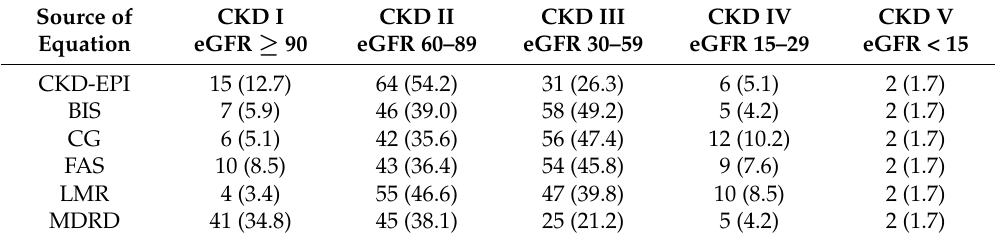
Table 3. Classification of chronic kidney disease stages based on the six different creatinine-based eGFR equations. Data are represented as the number (percentage) of participants in each chronic kidney disease stage (n = 118).